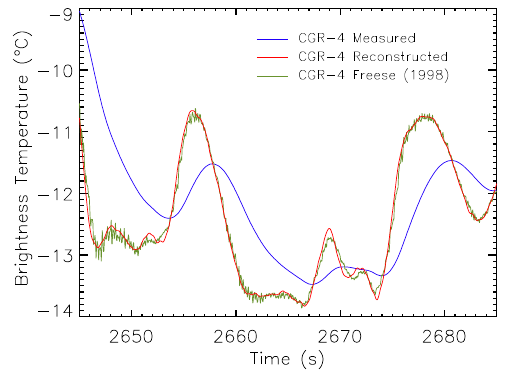
Figure 8. Comparison of reconstruction using the deconvolution method as described here and the approximation presented by Freese and Kottmeier (1998). The data are shown for the bro- ken clouds case of 15 May 2015. The measured CGR-4 data are smoothed by a moving average filter with 2.5s window length as used in the